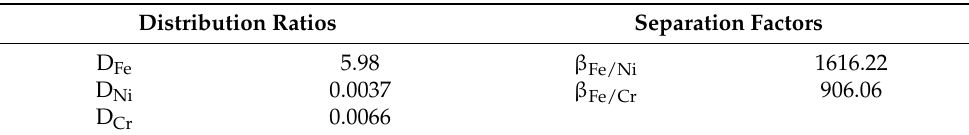
Table 4. Distribution ratios and separation factors of iron, nickel, and chromium after 0.1 mol/L